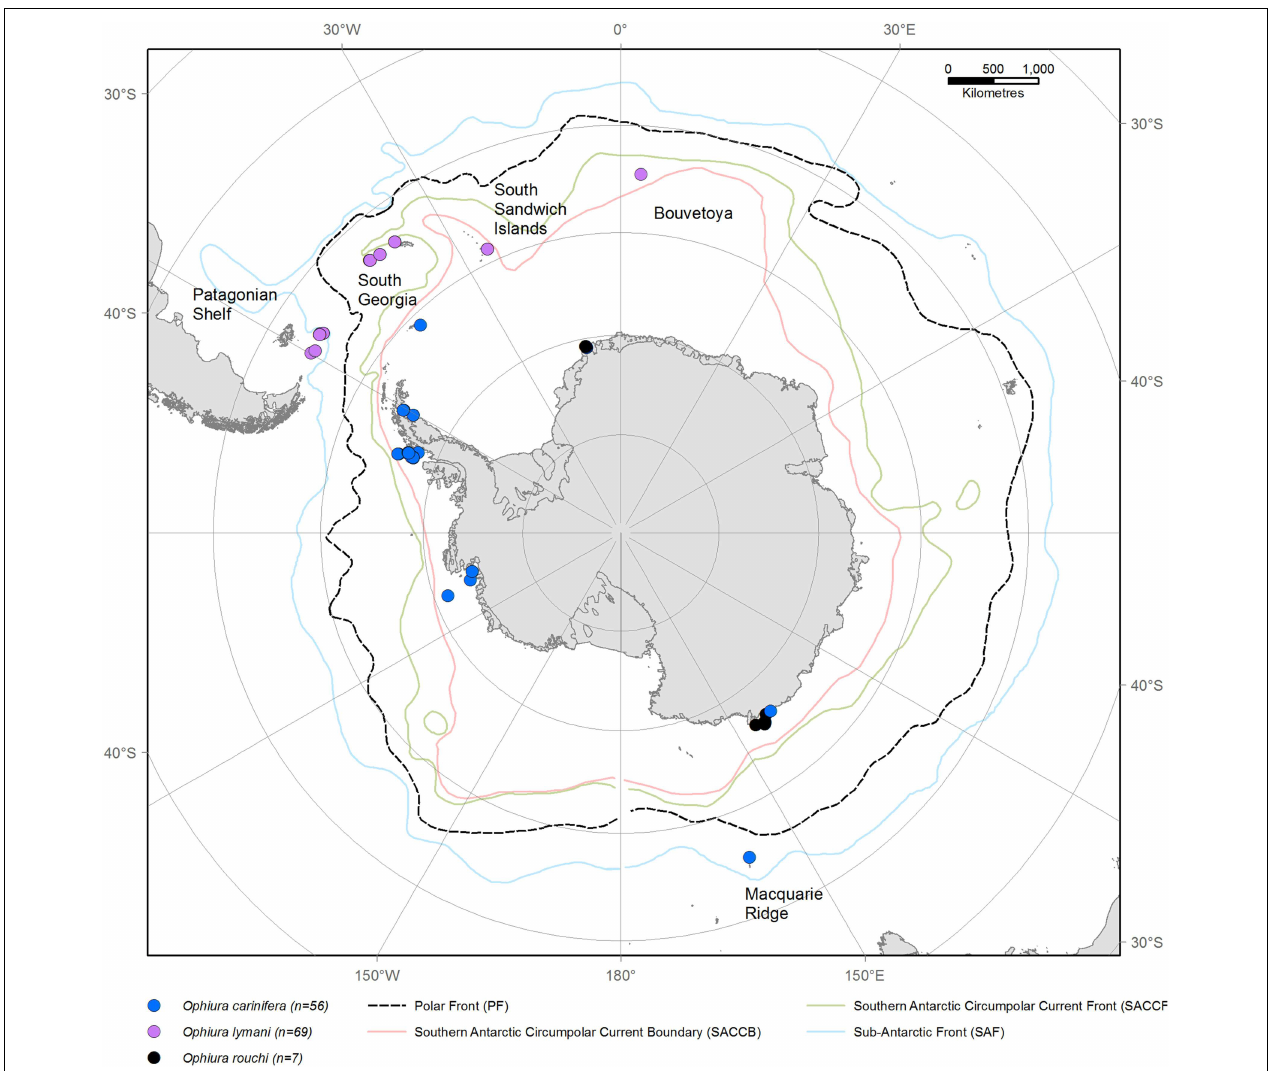
FIGURE 1 | Map of Antarctica and the Southern Ocean showing sampling locations of Ophiura lymani (purple) and Ophiura carinifera (blue) and Ophiura rouchi (green). The approximate positions of the fronts defining the ACC are indicated with the Polar Front indicated in a black dashed